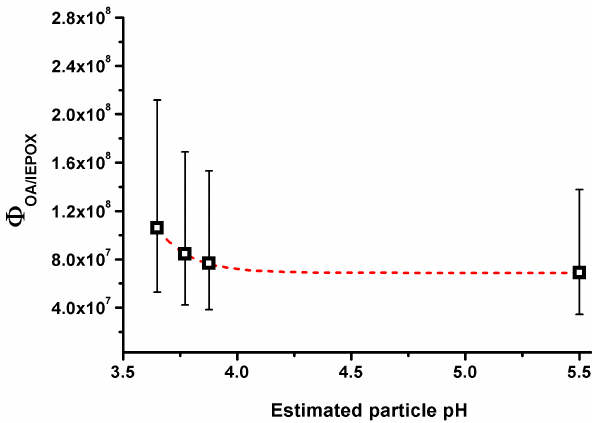
Fig. 3. 8 OA/IEPOX for the trans β -IEPOX isomer as a function of the modeled particle